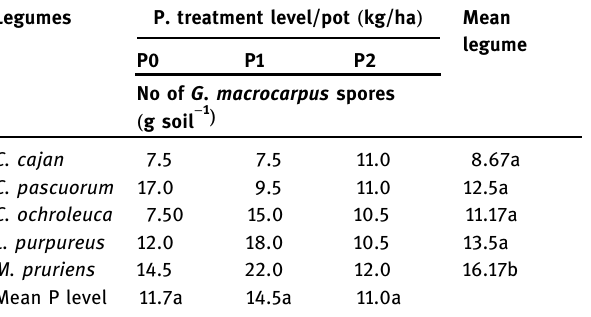
Table 4: E ff ect of phosphorus levels and studied legume species on spores of G. macrocarpus var. geosporus Legumes P. treatment level/pot ( kg/ha )